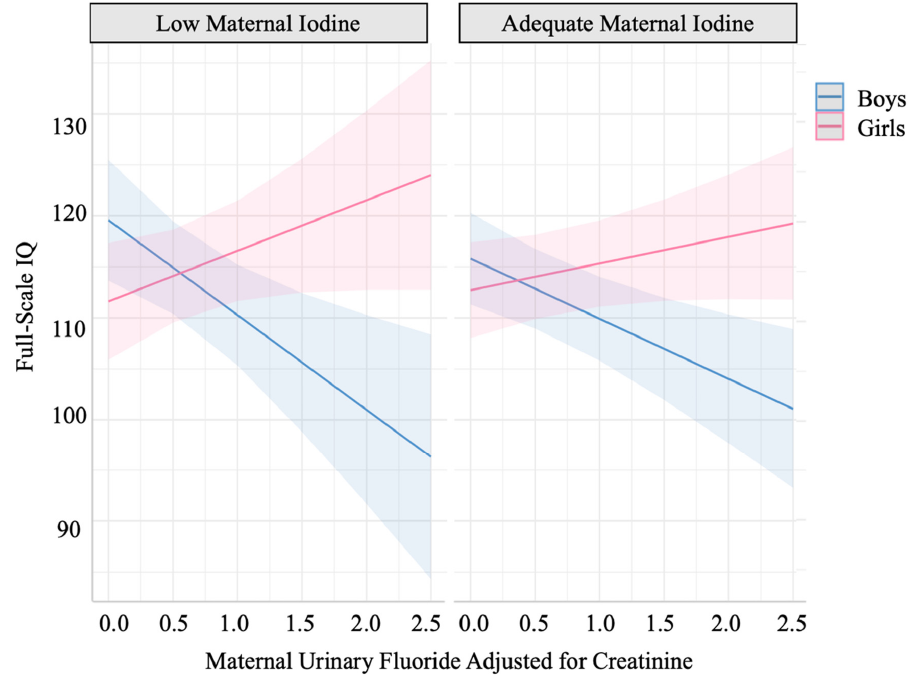
Figure 2. Model—implied three-way interaction between maternal urinary fluoride (MUF CRE ), maternal urinary iodine concentration (MUIC CRE ) and child sex. Every 0.5 mg/g increase in MUF CRE was significantly associated with a 4.65- and − 2.95-point lower FSIQ score for boys whose mothers had low MUIC CRE or adequate MUIC CRE , respectively. MUF CRE was marginally associated with FSIQ for girls whose mothers had low MUIC CRE and not significantly associated with FSIQ for girls whose mothers had adequate MUIC CRE .